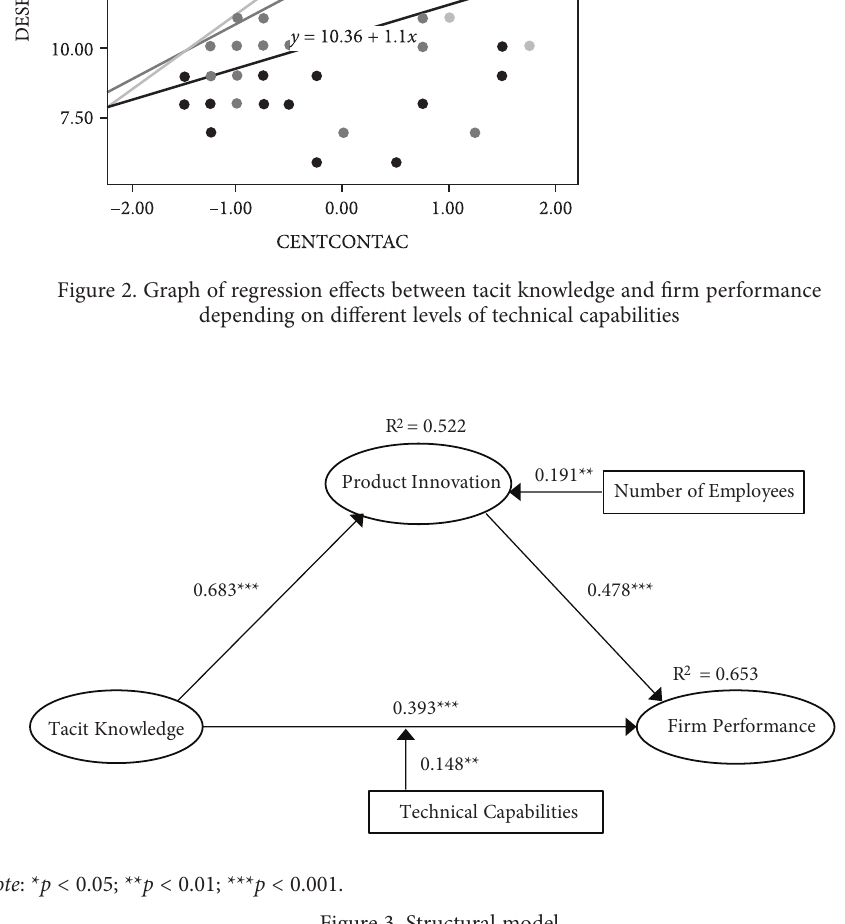
Figure 3. Structural